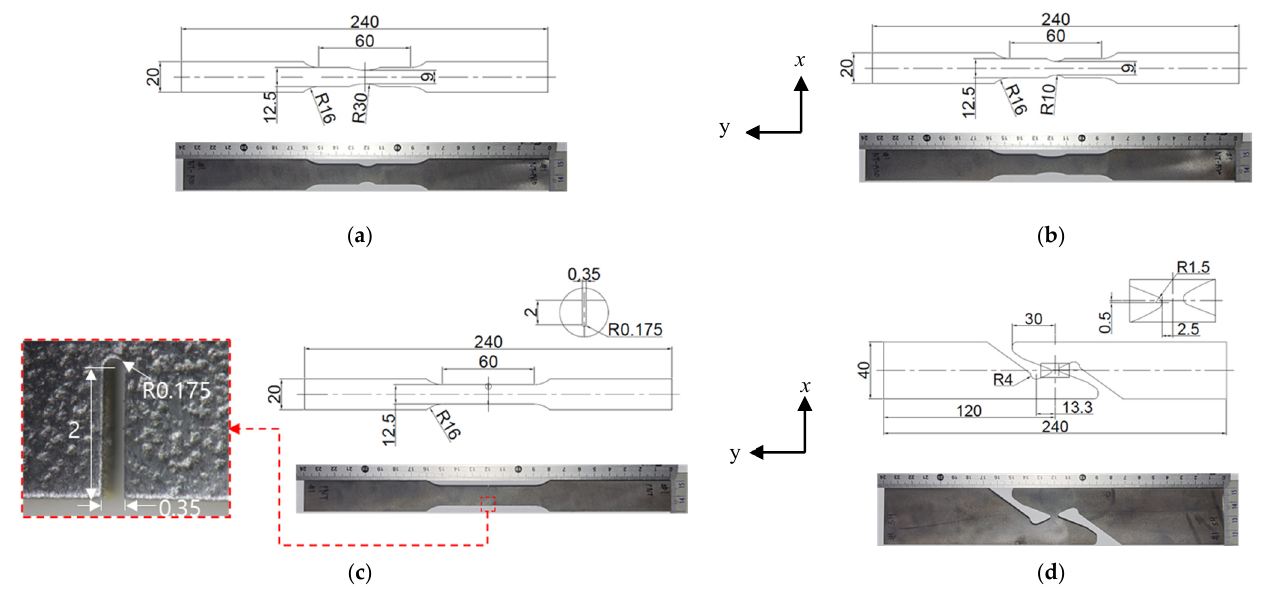
Figure 4. Types of specimens used for constructing 3D fracture locus of 3.0 wt% silicon steel: ( a ) NT10; ( b ) NT30; ( c ) SNT; ( d ) IPS. Unit is mm.